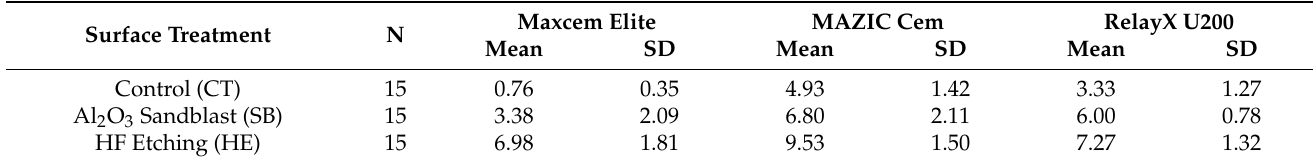
Table 3. Result of shear bond strength between surface treatments and resin cements ( p < 0.05). Surface Treatment